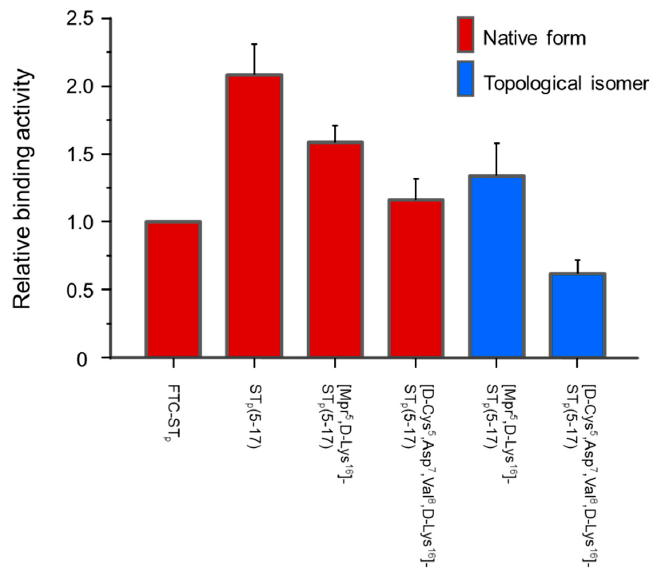
Figure 7. Competitive binding assay of the synthetic ST p peptides. The binding activity of the FTC- ST p peptide was normalized to a binding activity of 1.0. FTC-ST p peptide was normalized to a binding activity of